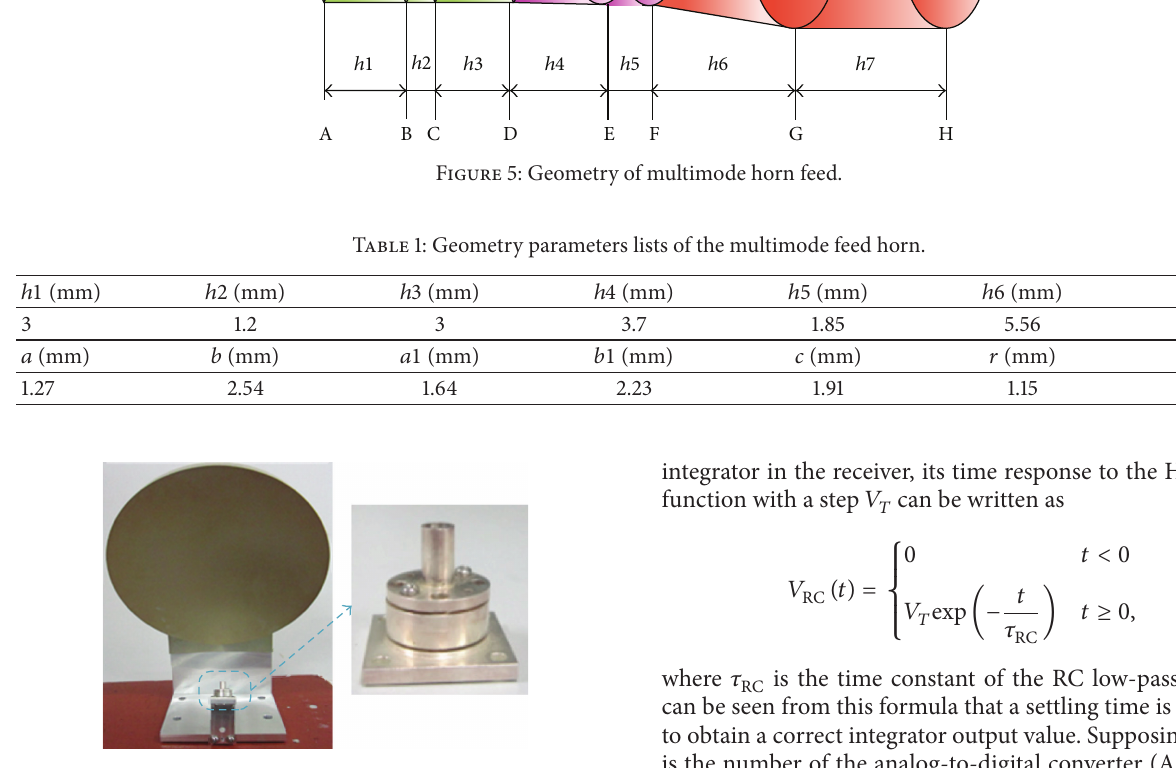
Figure 6: A picture of the designed W-band offset parabolic